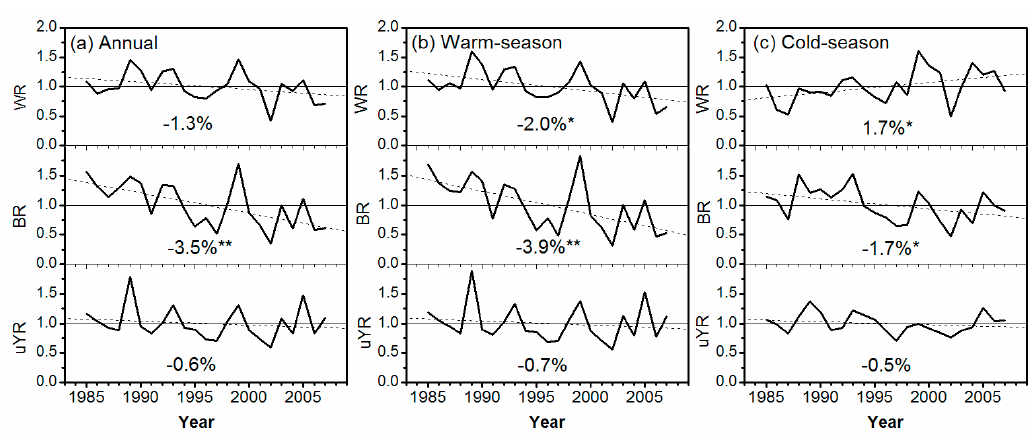
Figure 3. The normalized annual ( a ); warm season (from May to September) ( b ); and cold season (from October to April) ( c ) discharges of the WR, BR and uYR basins from 1985 to 2007. The dot dash lines indicate the regression lines of the discharge series. The numbers at panel bottom are the linear-regression slopes for the normalized discharges, while ** and * denote the significance levels p < 0.01 and p < 0.05, respectively.